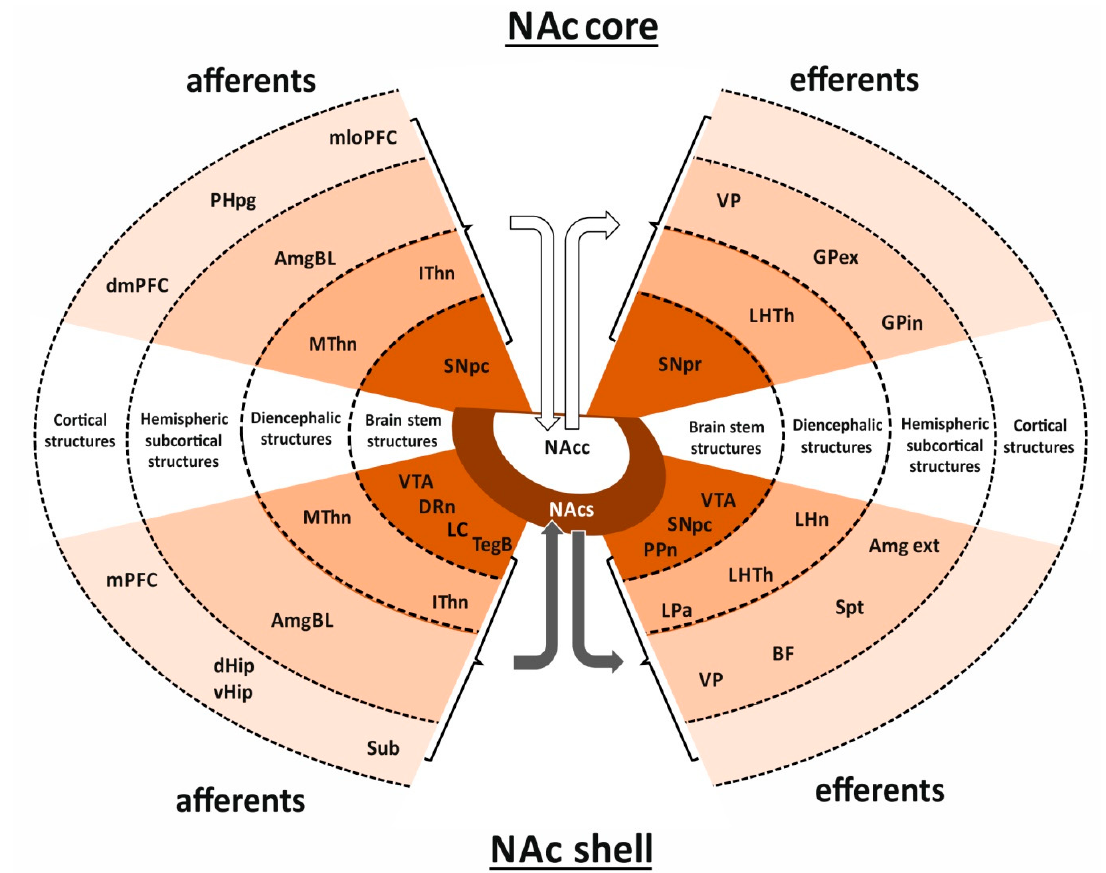
Figure 2. Hierarchical pattern of connections in the nucleus accumbens’ core and shell . There are significant differences between the NAcc and NAcs afferent and efferent connections. While afferent projections to NAcc originate from all structural levels i.e., cortical, hemispheric subcortical, diencephalic, and brain stem areas, its efferent projections mainly reach the subcortical brain structures and the brain stem. Afferent and efferent NAcs projections are more widely distributed and come from/to all brain structural levels. Furthermore, to a large extent they comprise other structures than those related to NAcc. This emphasizes the structural and functional differentiation between the two parts of NAc. The core of NAc receives afferents from the cortical limbic areas, such as the dorso-medial PFC (dmPFC; dorsal prelimbic, anterior cingulate cortex), medial and lateral orbital PFC (mloPFC), and para-hippocampal gyrus (PHpg). This part of the BRS also receives projections from the anterior part of AmgBL, as well as from the thalamic nuclei associated with nonspecific cortical stimulation (e.g., MThn and IThn). Finally, it is also a target of the brain stem projections originating from the motor system-related area in SNpc.